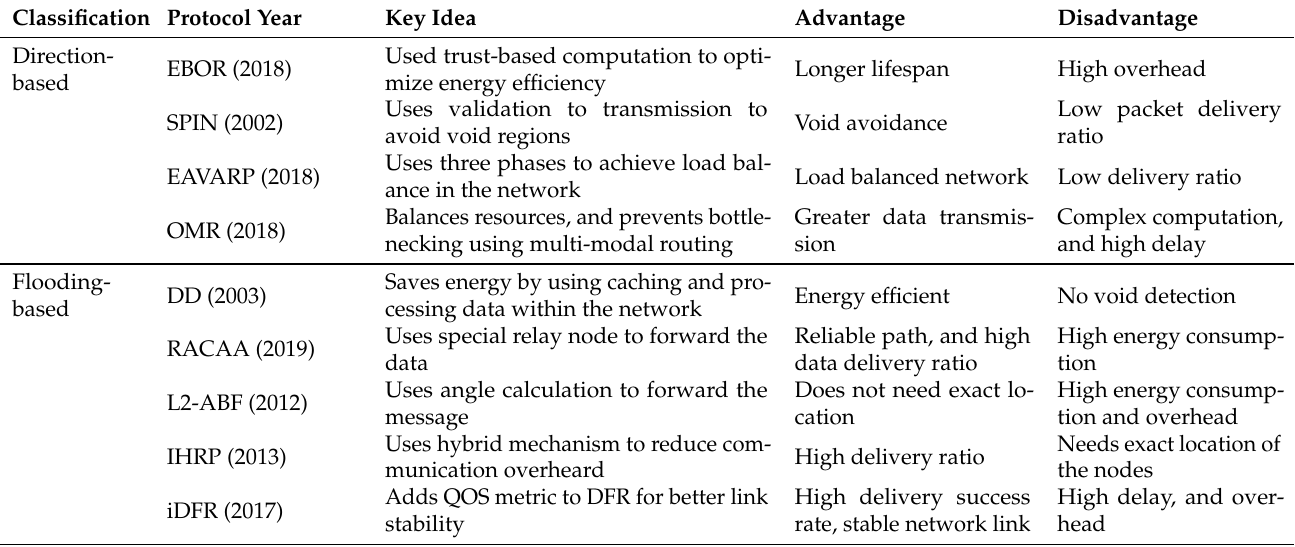
Table 19. Comparison of direction aware routing